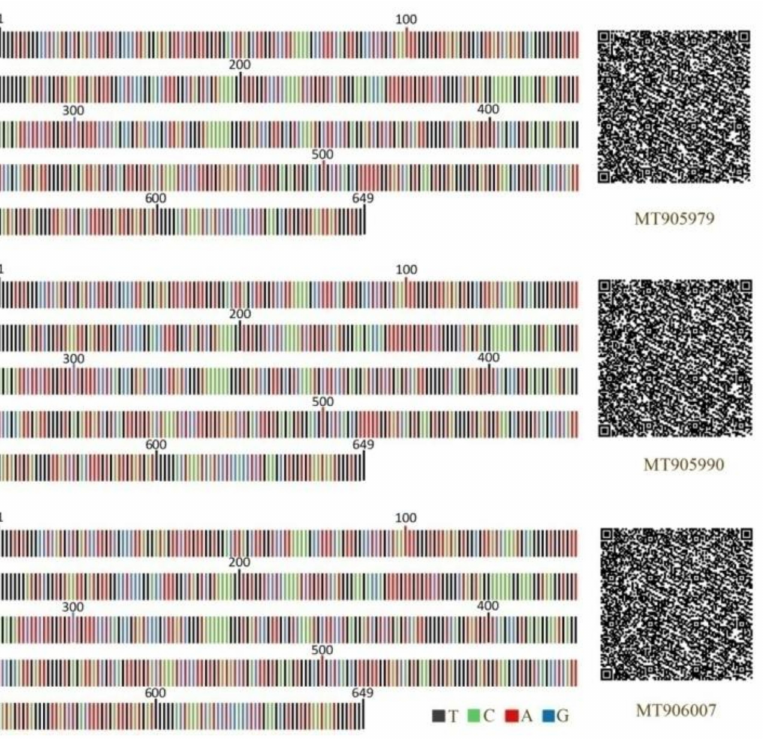
Figure 8. DNA barcodes and corresponding two-dimensional barcodes of partial specimens (MT905979, MT905990, MT90007) in this